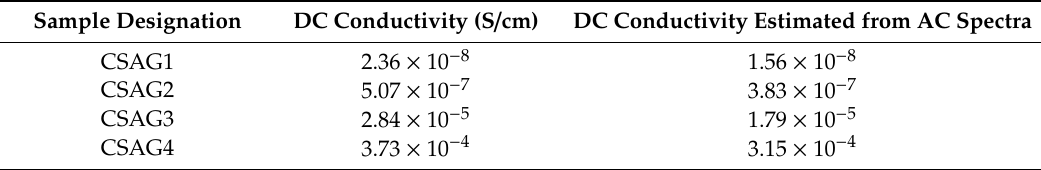
Table 2. Conductivity value of the CS–AgNO 3 –Al 2 O 3 –glycerol